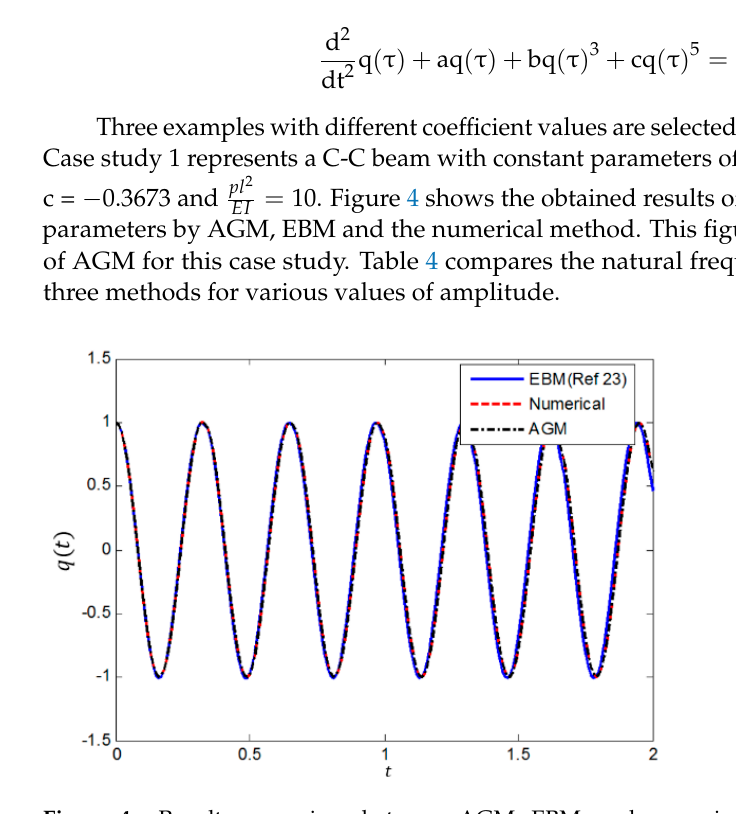
Figure 4. Result comparison between AGM, EBM, and numerical solution for case study 1